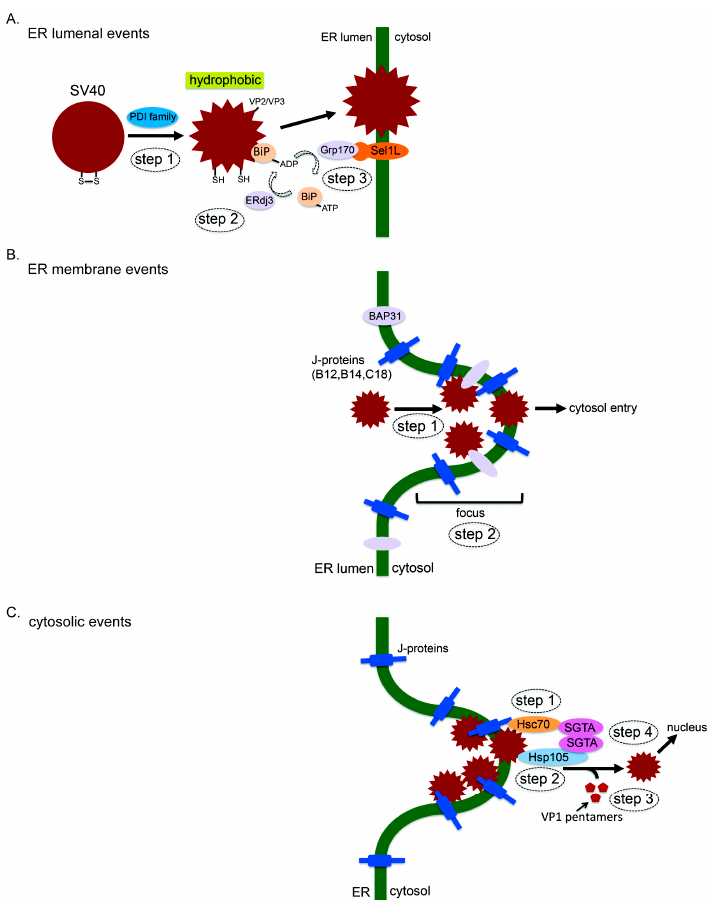
Figure 3. ER ‐ to ‐ cytosol membrane penetration of SV40. Penetration across the ER membrane to